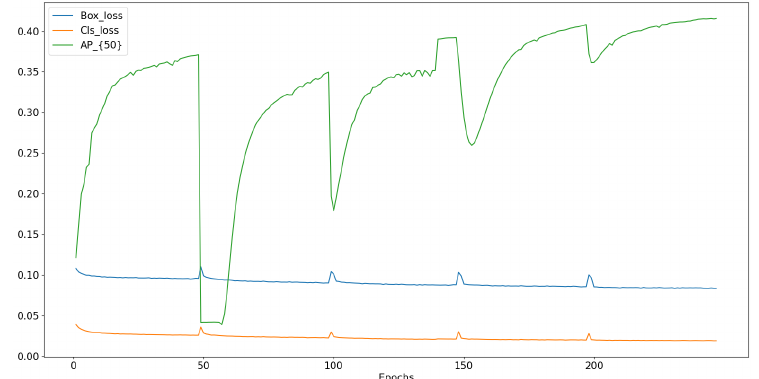
Figure 6. Curves of L DR on the training set for medium rain.